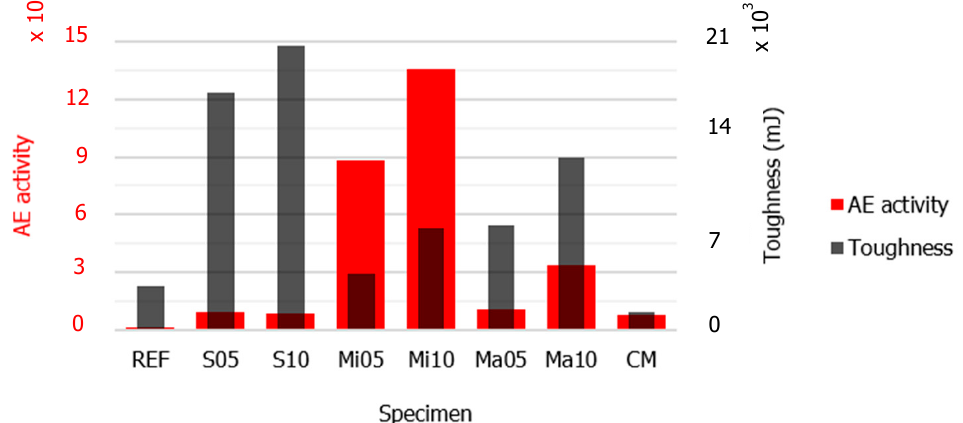
Figure 6. AE activities of the specimens.